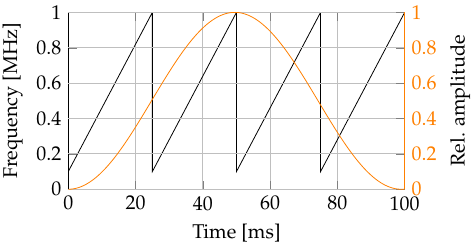
Figure 5. Frequency curve as well as window function during a single measurement. VersionMay23,2018submittedto Sensors